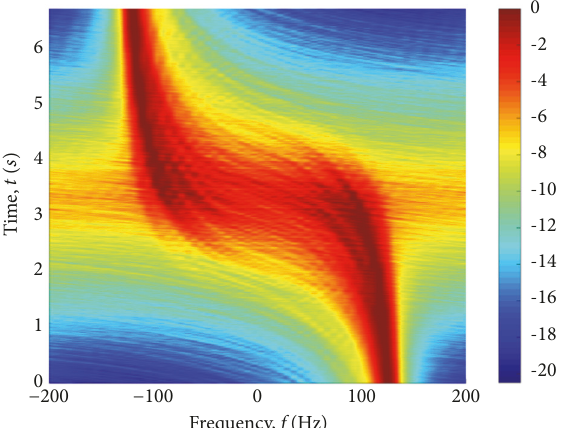
Figure 6: Theoretical TV-DPSD 𝑆 𝑝𝑞 (𝑡, 𝑓) ( 𝐾 𝑝𝑞 = 0).